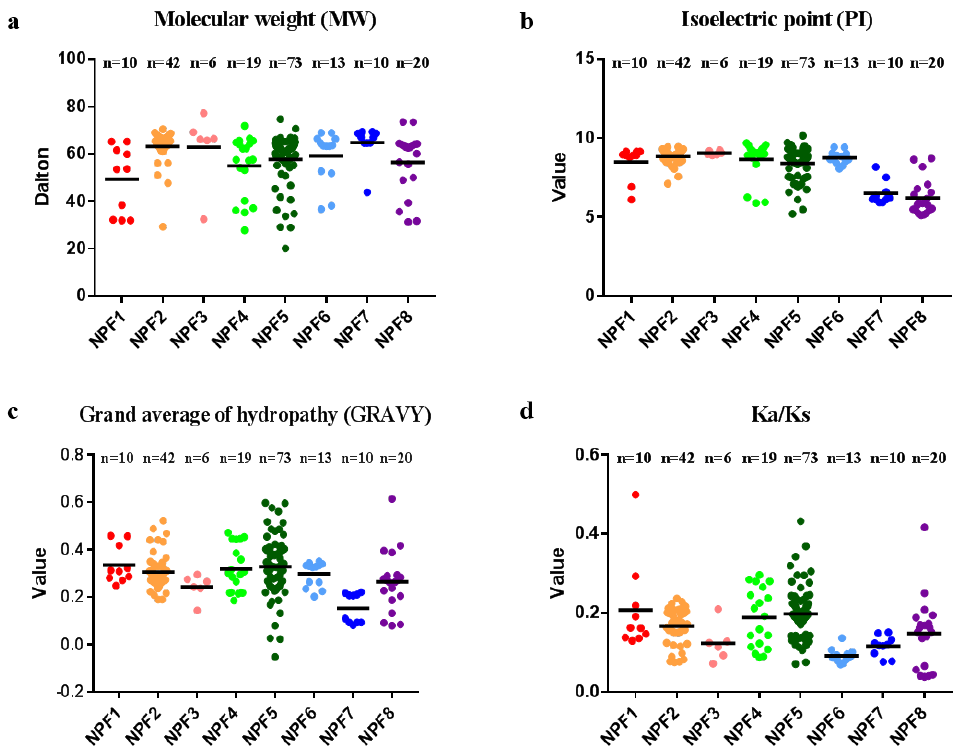
Figure 2. Molecular characterization of the NPF proteins in Brassica napus . ( a ) molecular weight (MW); ( b ) theoretical isoelectric point (PI); ( c ) grand average of hydropathy (GRAVY); ( d ) Ka/Ks values.